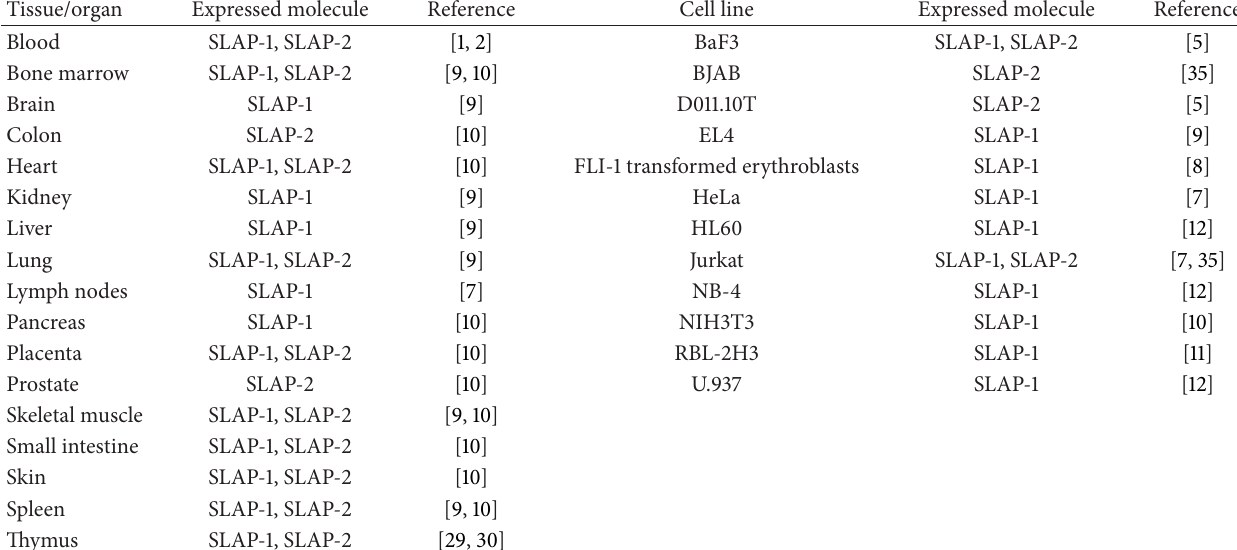
Figure 1: The schematic structure of SLAP molecules. SLAP-1 and SLAP-2 contain unique carboxy-terminal sequences, common SH2- SH3 domains and amino-terminals which exist in myristoylated and nonmyristoylated isoforms. SH2 domains help molecules to bind to phosphorylated tyrosine containing epitopes. The SH3 domains connect the proline and hydrophobic amino acid containing molecules. Table 1: The expression of SLAP proteins in different tissues and cell